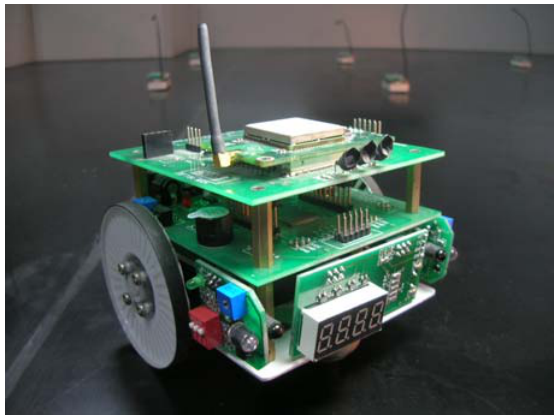
Figure 3. A prototype of the mobile node.